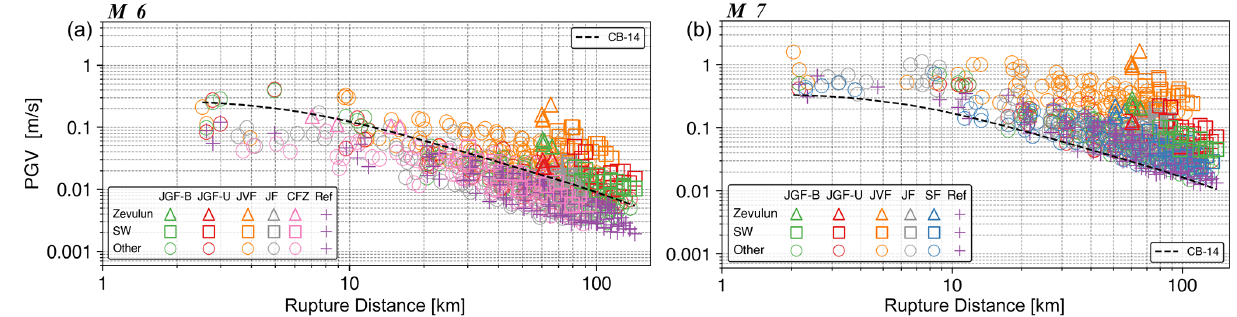
Figure 5. Simulation results and PGV distance space for bilateral rupture on the Jordan Gorge Fault (JGF-B), Jericho Fault (JF), Carmel Fault Zone (CFZ; for M 6), and the Shemona Fault (SF; for M 7), a southward unilateral rupture on the JGF (JGF-U), and a super-shear rupture on the Jordan Valley Fault (JVF) for M 6 (a) and M 7 (b) . The records from Zevulun Valley and the sedimentary wedge (SW) are marked with triangles and rectangles, respectively. The other records are marked with circles; the reference records are marked with pluses. For comparison, the CB14 is plotted for a strike-slip fault, Z 2 . 5 = 0 . 42km and V s30 = 1686ms − 1 (representing averaged values over all the